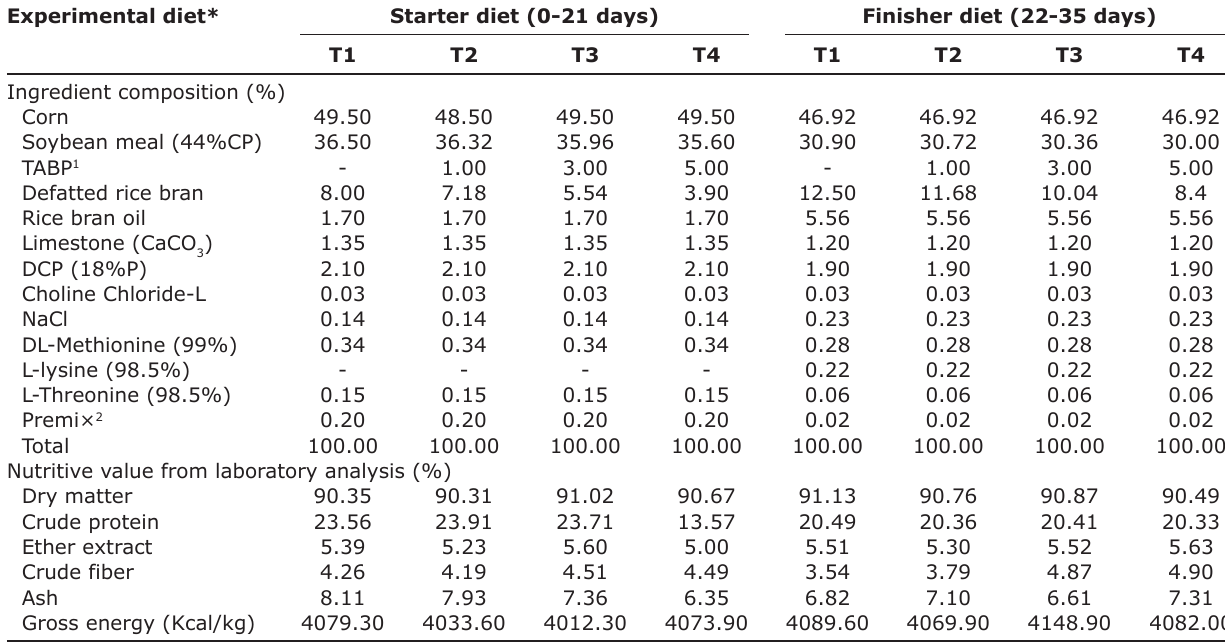
Table-1: Ingredient composition and nutritive value of the experimental diet. Experimental